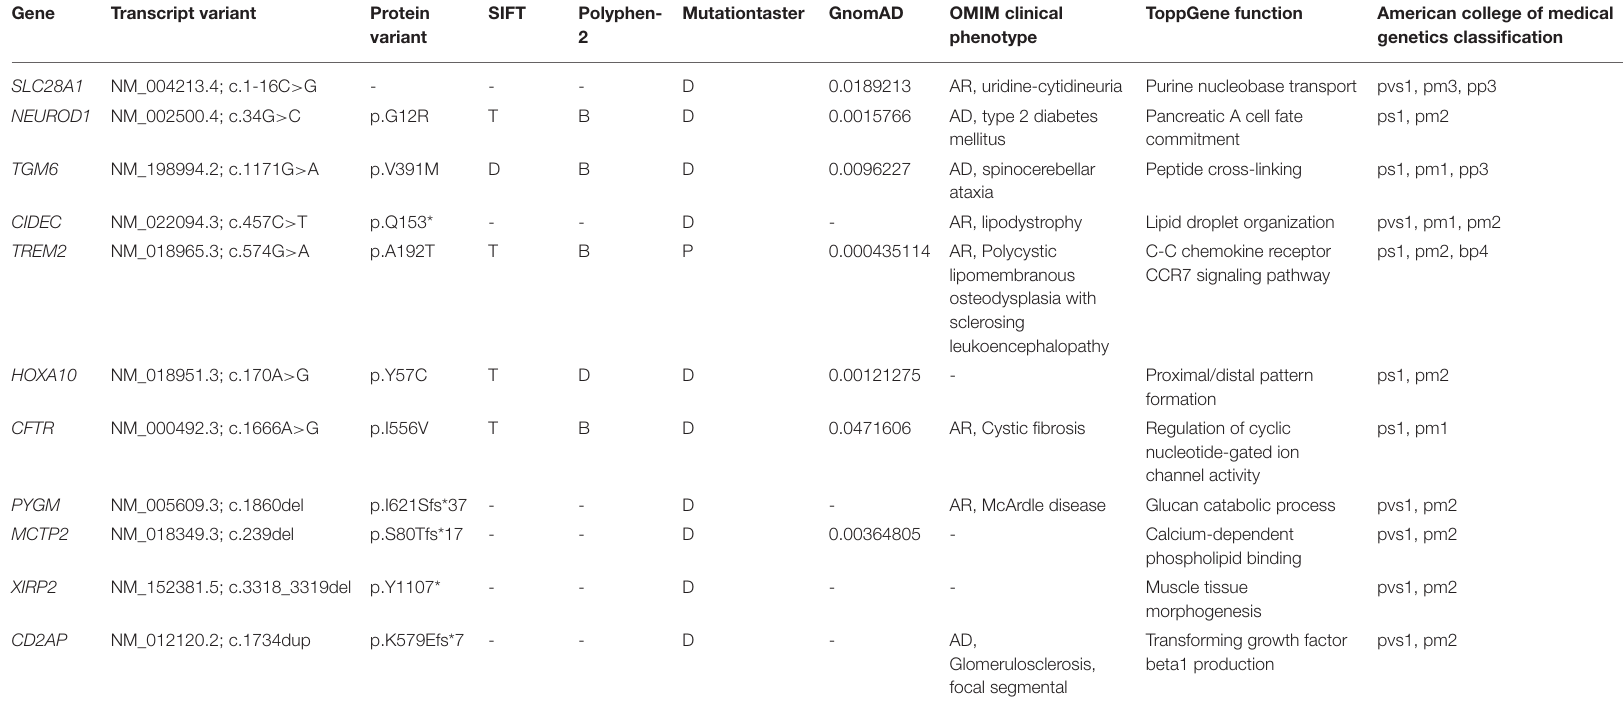
TABLE 2 | Variants identified by WES in this